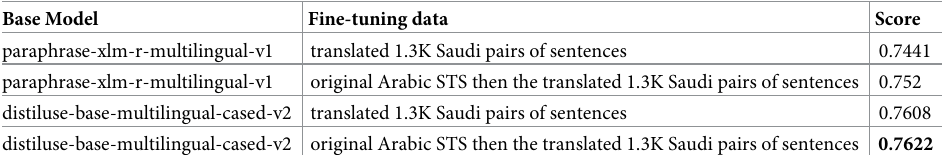
Table 6. Accuracy of main Saudi Arabian models based on Spearman rank correlation between the cosine similar- ity of sentence representations and the reference labels of the testing dataset in [8] after translation to Saudi